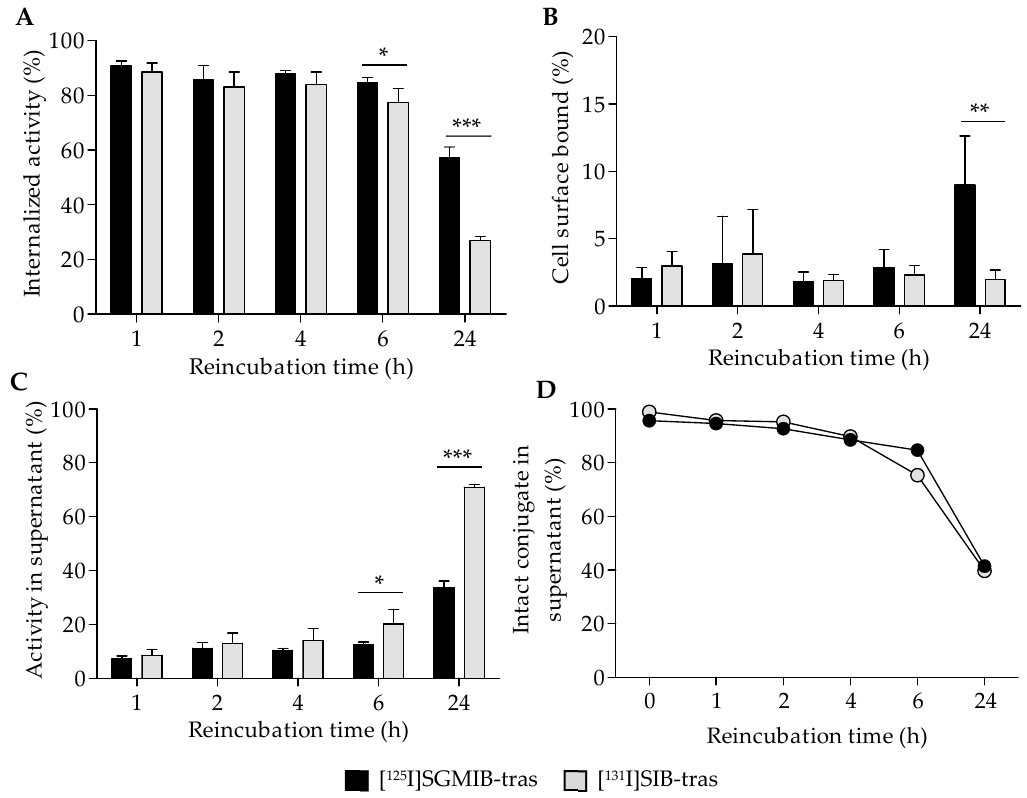
Figure 3. Distribution of initially bound radioactivity (shown in Figure 2B) in BT474 cells and the supernatant for [ 125 I]SGMIB-trastuzumab and [ 131 I]SIB-trastuzumab. Percent of the total cell-associated activity that had internalized into cells ( A ), bound to the cell surface ( B ), or released back into the supernatant ( C ) with time at physiologic conditions (37 °C). ( D ) Protein-associated activity in cell supernatants determined by the TCA precipitation assay. * p < 0.05, ** p < 0.01, *** p < 0.001.